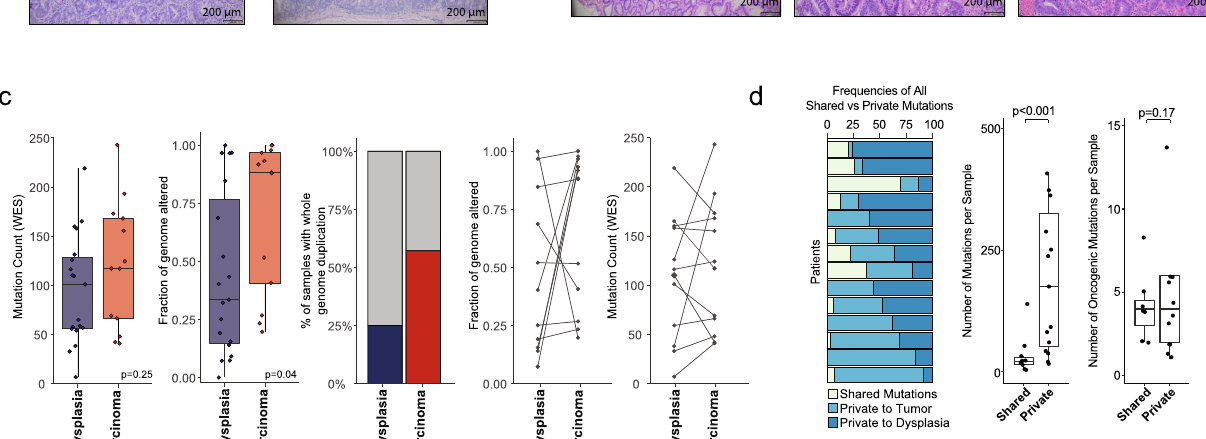
sequencingbetweendysplasia( n =19)andCAC( n =12). d Frequencyofprivateand sharedgenomicalterationsbetweenpatientswithbothadysplasiaandCACsample ( n =15). In the left box plot, the number of shared and private mutations (all mutations)perpairofsampleswerecompared( P =0.00022).Intherightboxplot, the number of shared and private mutations (driver mutations only) per pair of samples were compared ( P =0.17). In the box plots in panels c and d , statistical signi fi cance was assessed using a two-sided Mann – Whitney U -test. The center line of the box plots indicates the median, edges indicate the interquartile range, and the whiskers extend to the highest and lowest values not considered outliers. Source data are provided as a Source Data fi le. AOM azoxymethane, DSS